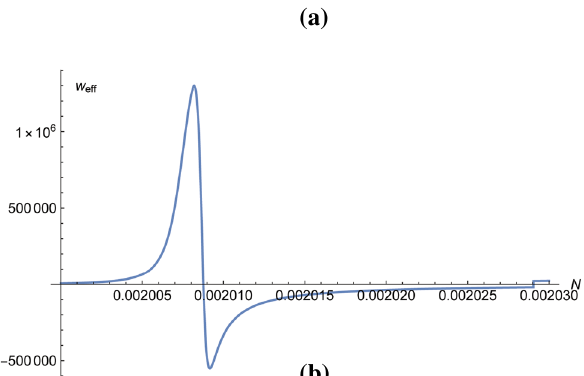
tom region ( χ 1 ( N = 0 ) = 100 , χ 2 ( N = 0 ) = 10) and after